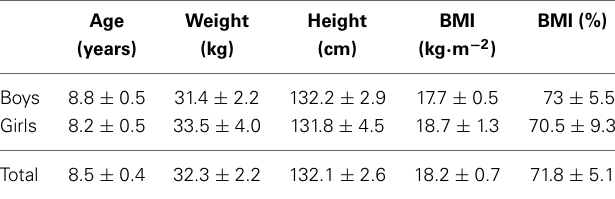
Table 1 | Physical